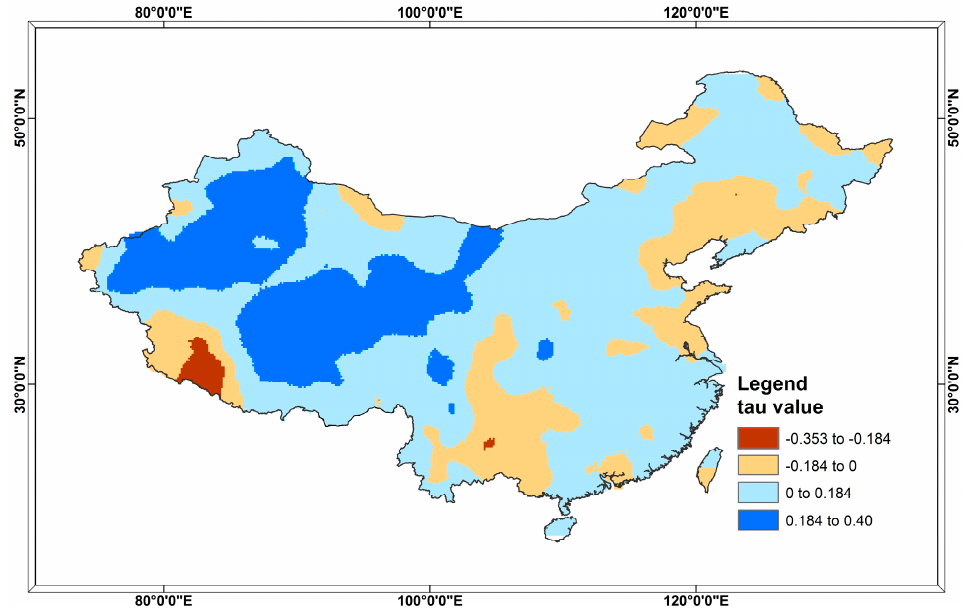
Figure 5. Spatial distribution of Mann-Kendall test tau value of SPI time series for all 3804 stations from 1961 to 2014 in China. Tau ≤ − 0.184 indicates a significant downward trend, − 0.184 ≤ tau ≤ 0 indicates a downward but not significant trend; 0.0 < tau < 0.184 indicates an upward but not significant trend; tau ≥ 0.184 indicates a significant upward